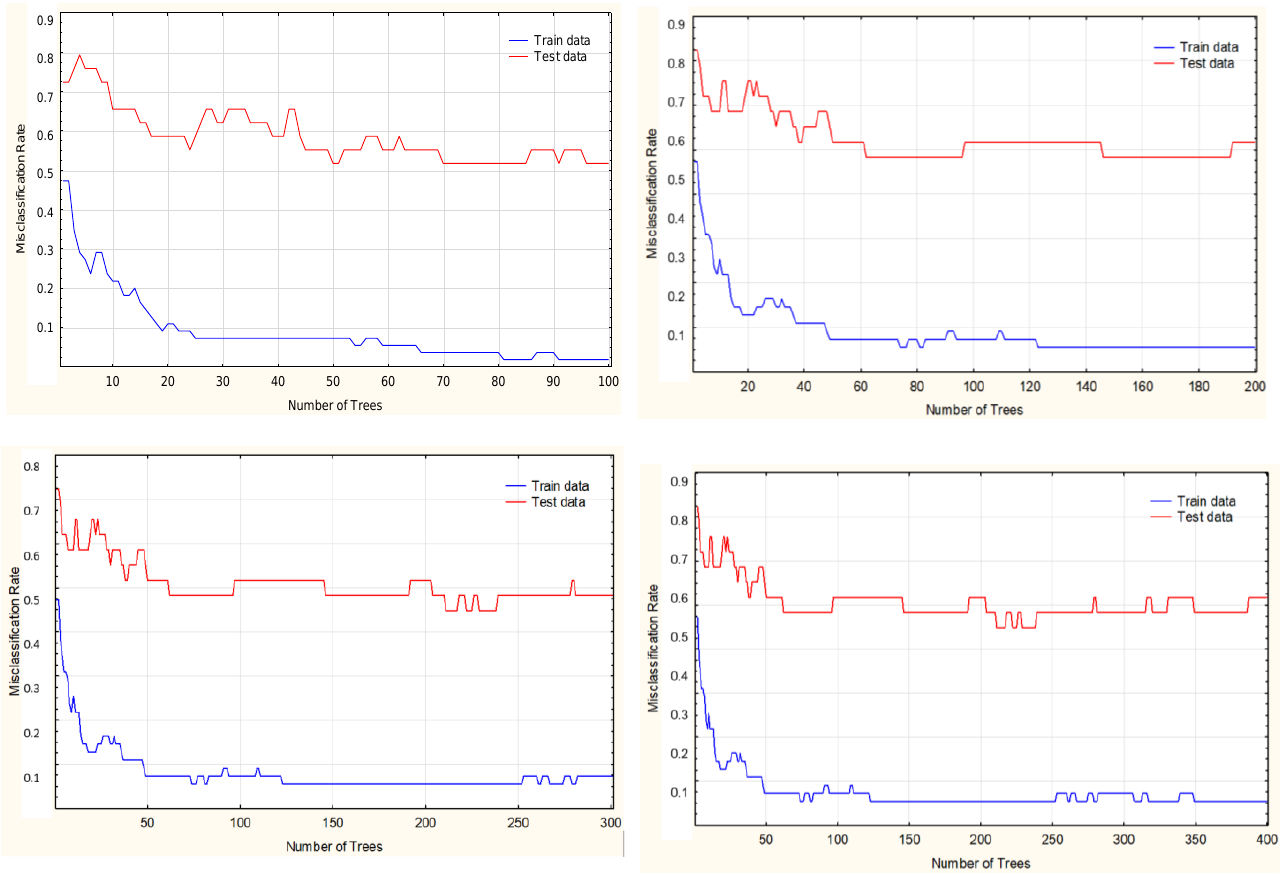
Figure 2. Plots of misclassification coefficients by successive tree addition steps (given number of solver trees, tmax = 100, tmax = 200, tmax = 300, and tmax = 400). However, in the test samples for all variants of the investigated sets of decision trees in «random forest» ( tmax = 50, 100, 150, 200, 250, 300, and 400) there is almost a 50% risk of misclassification of trees (interval A r = (0.471651; 0.579786). Table 2 presents the risk estimation for the training and test samples. For our classification problem, where the condition is the presence of a categorical dependent variable (Pc_dep—level of digitization of telecommunication networks) and equal misclassification costs, the risk as the fraction of cases misclassified by trees is